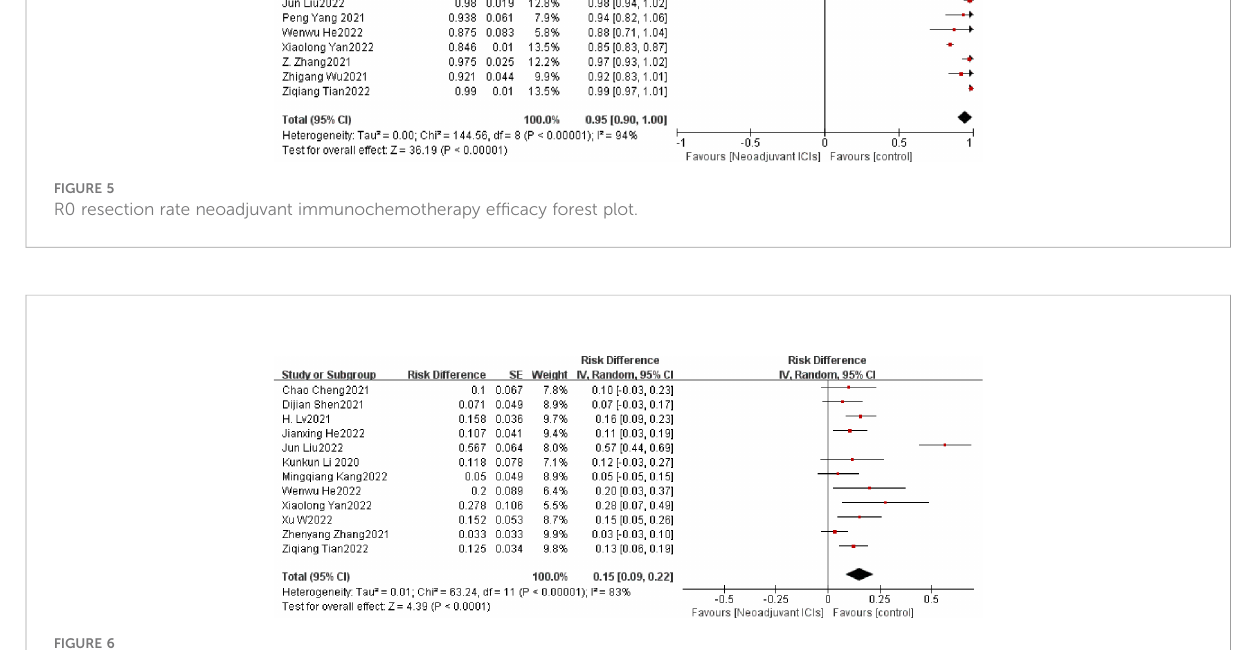
FIGURE 6 TRAEs incidence neoadjuvant immunotherapy chemotherapy forest